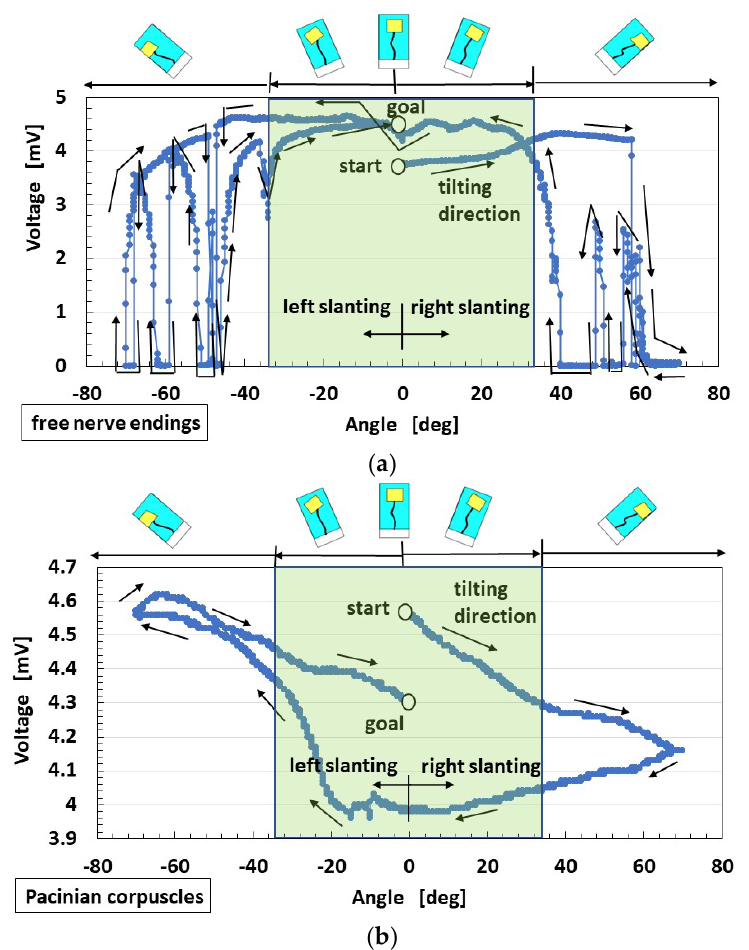
Figure 11. Experimental results of the slanting equilibrium sensor: ( a ) with free nerve endings and ( b ) Pacinian corpuscles.